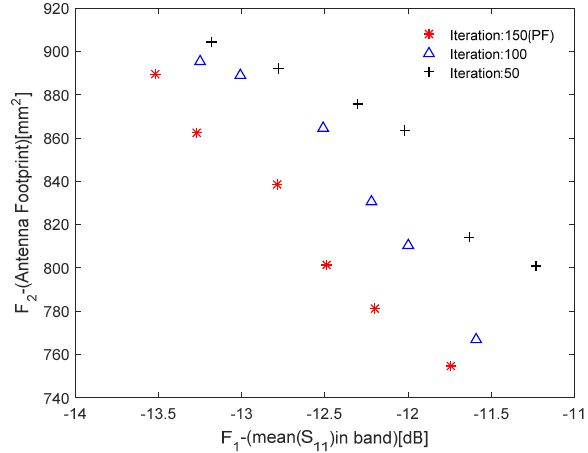
Figure 11. The obtained representations of the Pareto set for the planar multiband antenna.